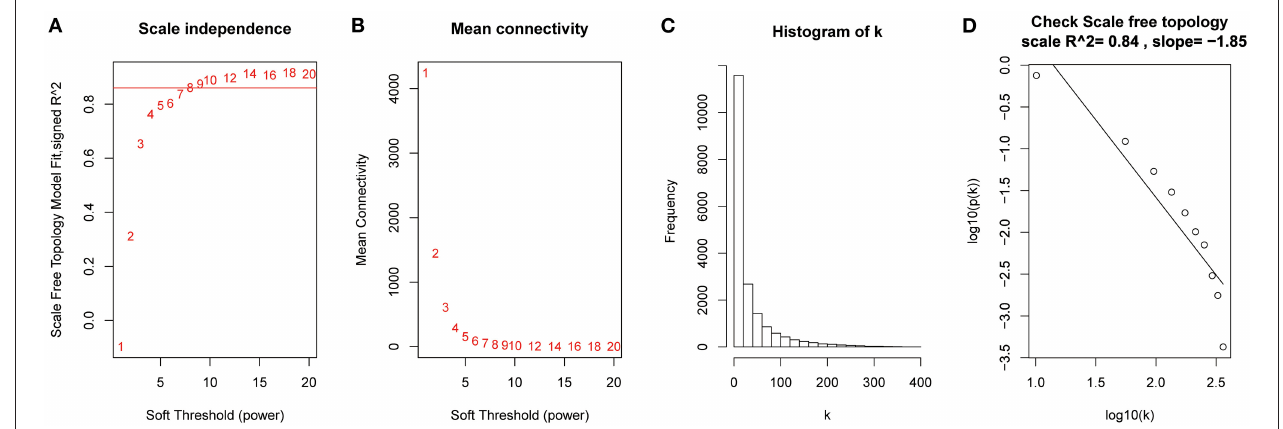
FIGURE 2 | Determination of soft-thresholding power in the weighted gene co-expression network analysis (WGCNA). (A) Analysis of the scale-free fit index for various soft-thresholding powers ( β ). (B) Analysis of the mean connectivity for various soft-thresholding powers. (C) Histogram of connectivity distribution when β = 8. (D) Checking the scale-free topology when β =